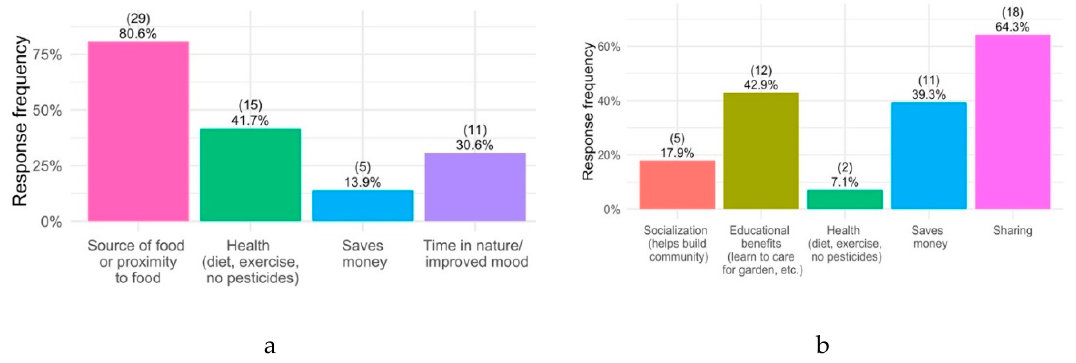
Figure 1. Most common perceived benefits of home gardeners (a) and community gardeners (b).